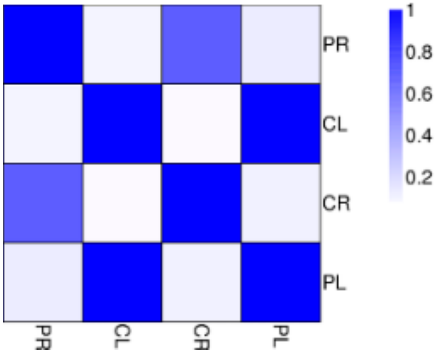
Figure 2. Correlations of samples. CL: Aboveground part of WT; CR: Root of WT; PL: Aboveground section of − P treatment; PR: Root of − P treatment.